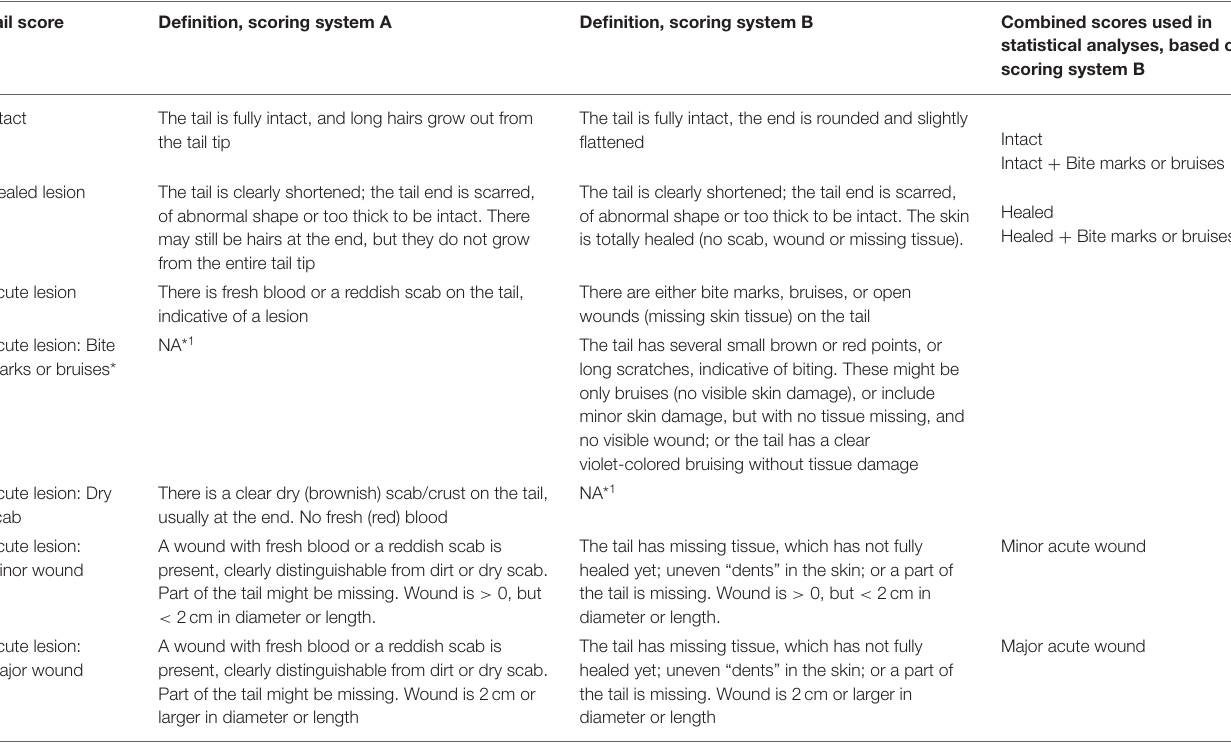
TABLE 1 | Tail scoring system used at the slaughter